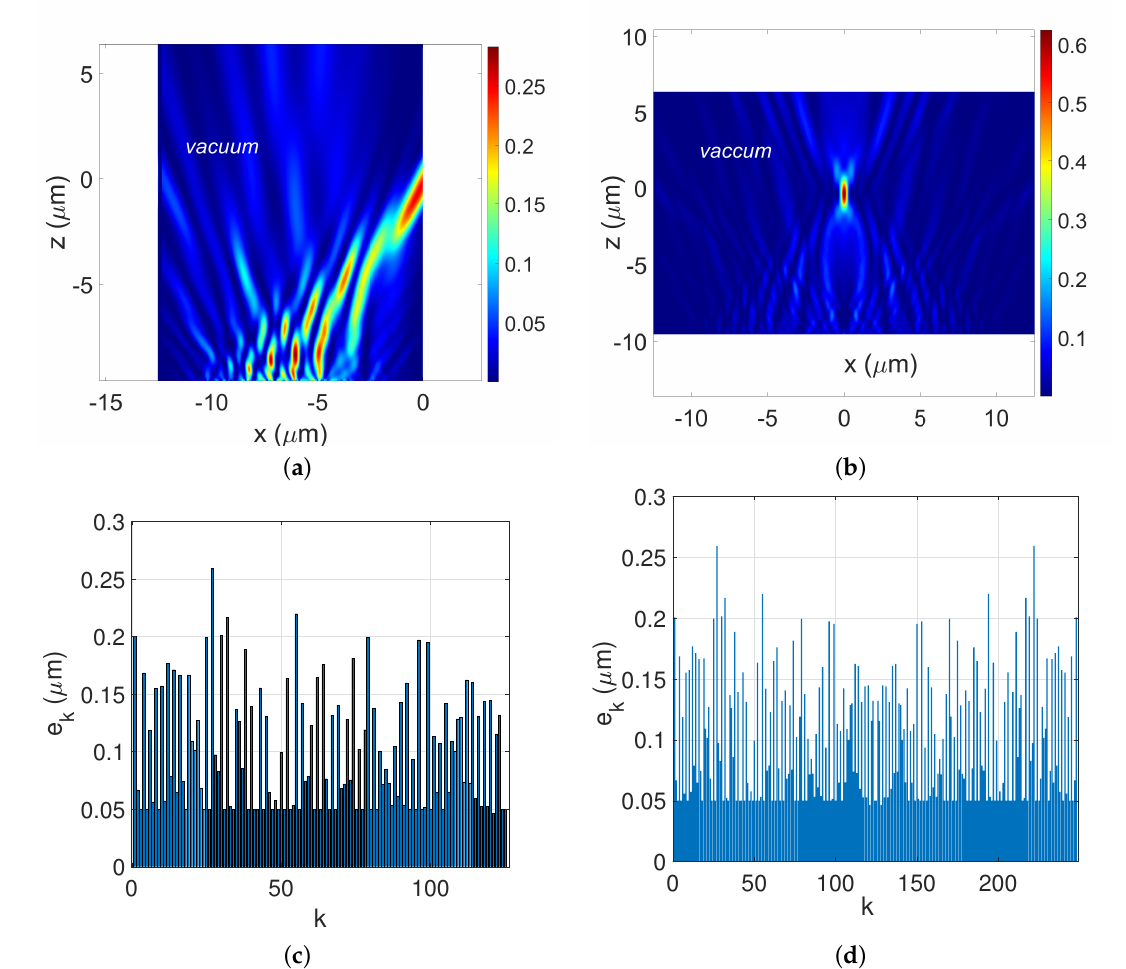
Figure 8. Design of a plasmonic silver-flat-metalens of d = 24.99 µ m-wide consisting of N p = 248 silver-nanoridges and nanoslits focusing a normal incident TM-polarized plane wave at a wavelength λ = 0.637 µ m at a distance of 15 λ . ( a , b ) presents the cartography of the normalized magnetic field intensity in the plane ( X , O , Z ) . ( c , d ) shows the values of the (nanoridges, nanoslits)-widths sequence [ e k ] k with respect to their locations labelled by k . Numerical parameters: λ = 0.637 µ m, N p = 125,